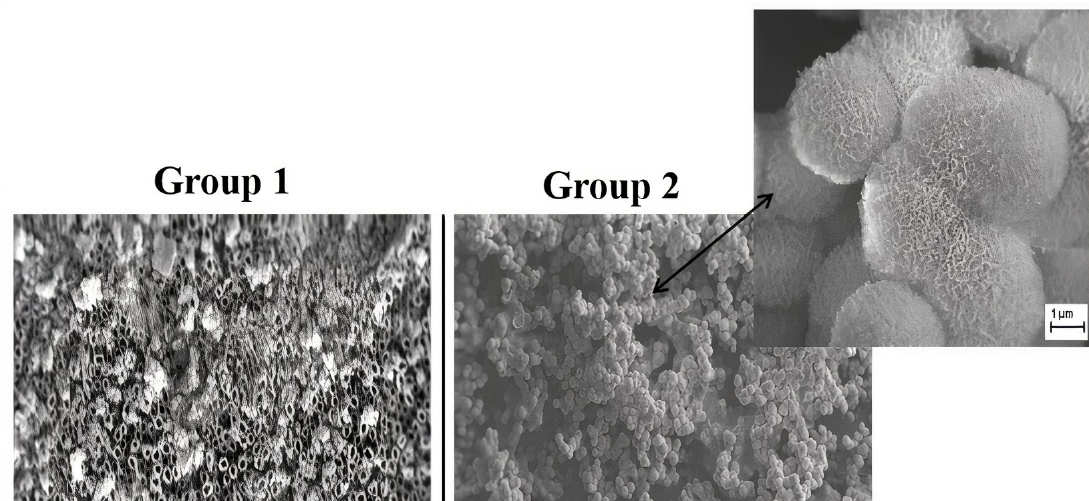
nanotube) and Group 2 (TiO 2